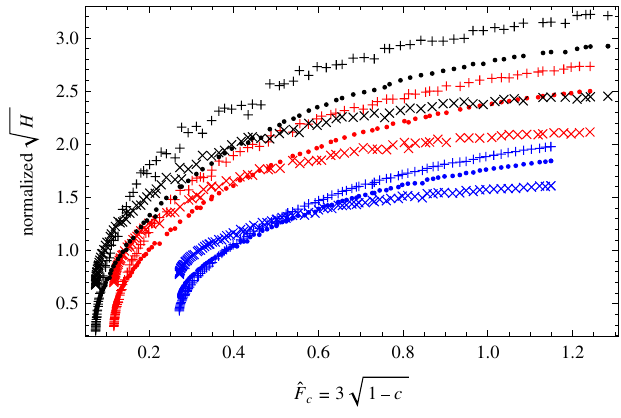
FIG. 15. Relative changes in the square root of dispersion action in the inner matching section of symmetric double-bend cells for the optimal solutions. Lattices are marked by AME ( (cid:2) ), TME ( þ ), and EME ( (cid:7) ). Peak-field strength factors are 2 (blue), 4 (red), and 6